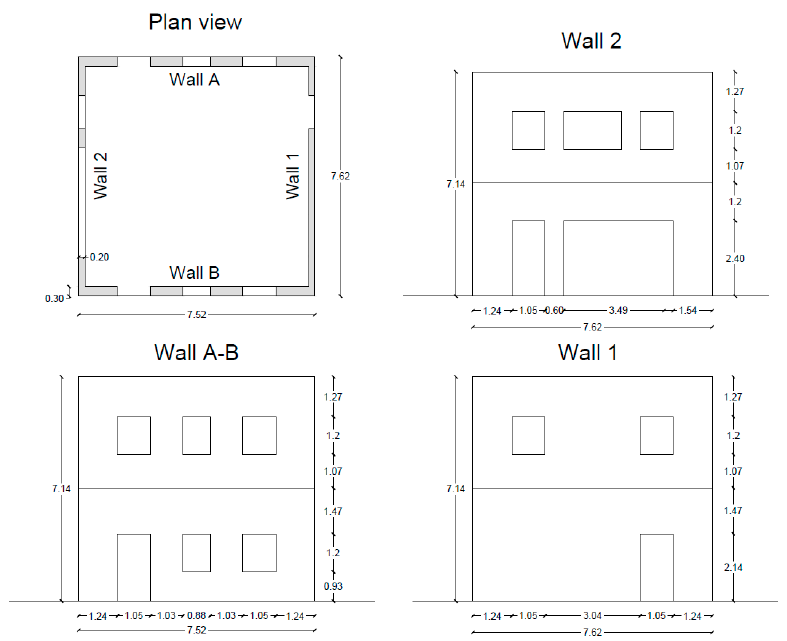
Figure 4. Sketch of the two story masonry structure tested at Georgia Tech laboratory [22], plan view and elevation.